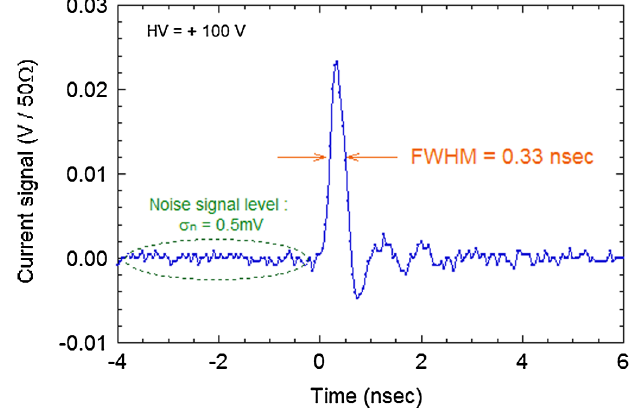
FIG. 4. Pulse shape of current signal of the diamond-based